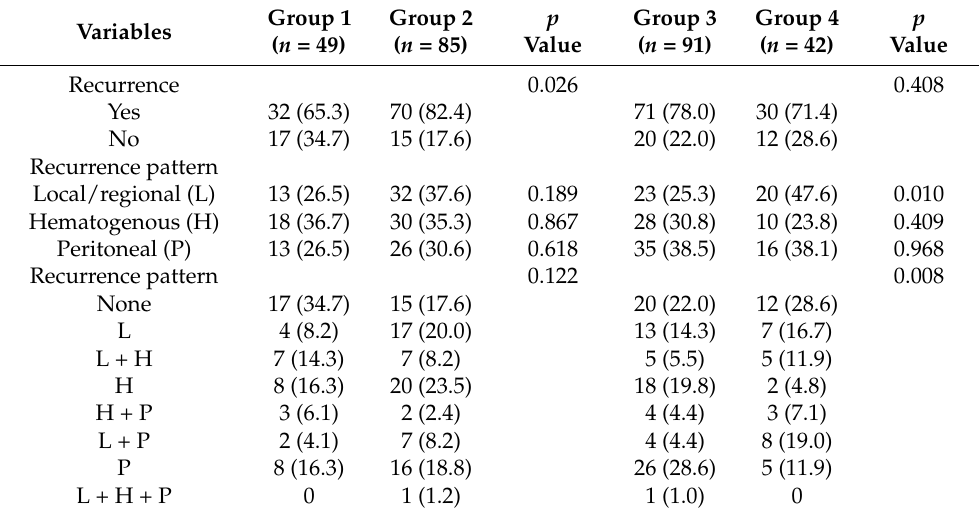
Table 7. Recurrence rate and